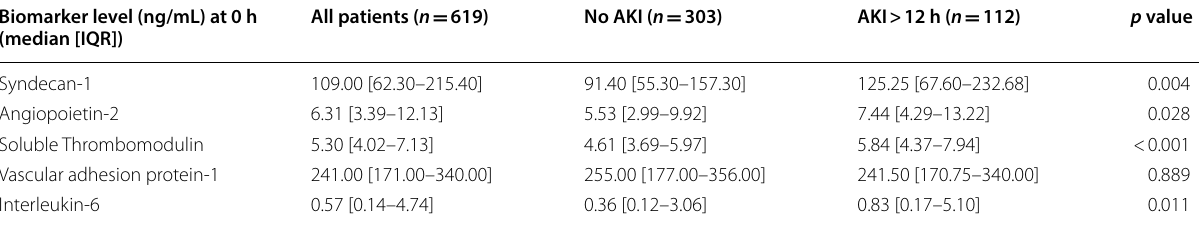
AKI > 12 h; AKI diagnosed over 12 h from ICU admission to day 5 or ICU discharge, if earlier